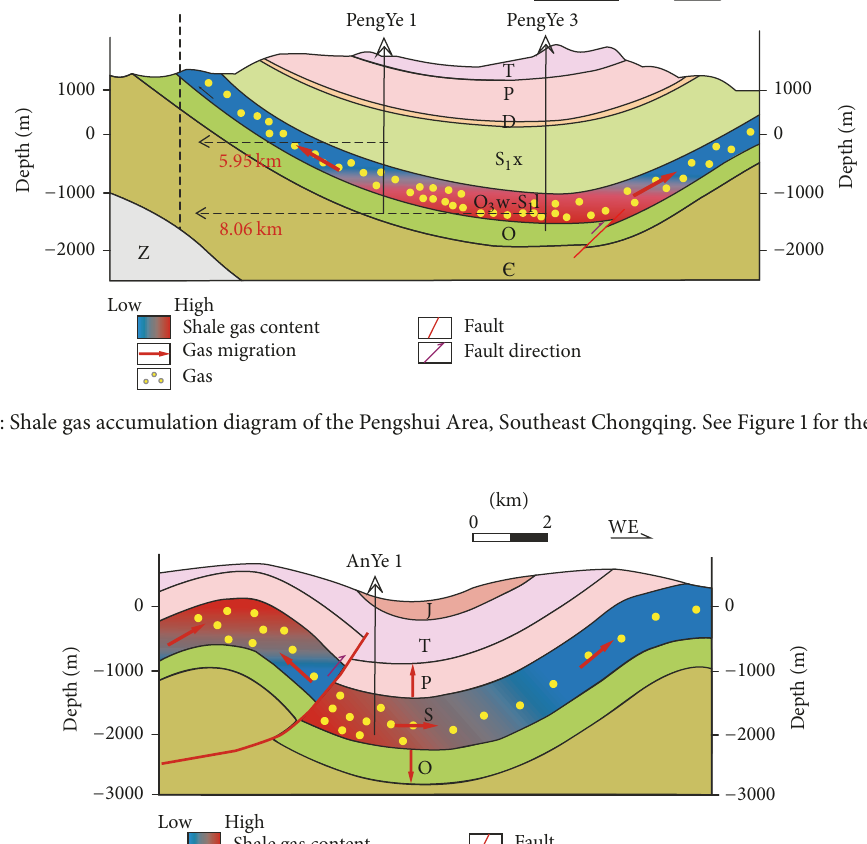
limbs along the direction parallel to the plane, while a small part of it would diffuse vertically into the surrounding rock. left limb, shale gas would accumulate in the footwall of the fault. Due to exposure of the shale layer at the surface, gas of the right limb would be lost (Figure